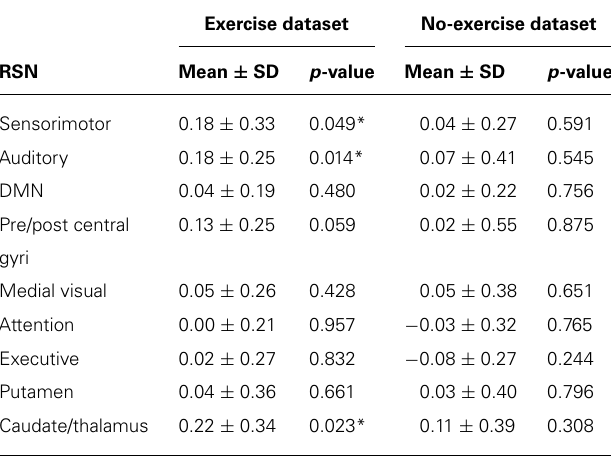
Table 3 | Cohen’s D effect size comparing pre- vs. post- (exercise) and session 1 vs. 2 (no-exercise) using theVISTAR Pipeline. Exercise dataset